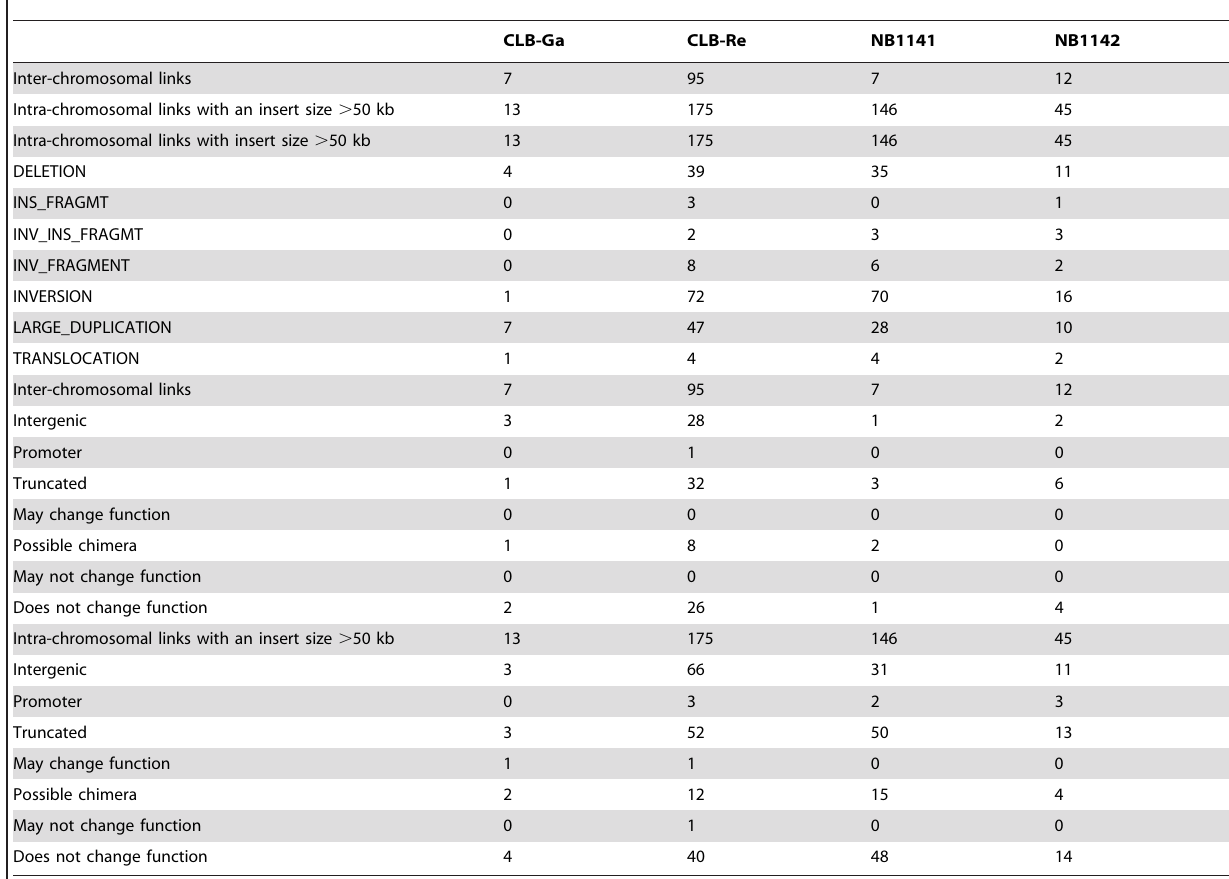
Table 2. Inter and large intra-chromosomal rearrangements predicted by SVDetect.